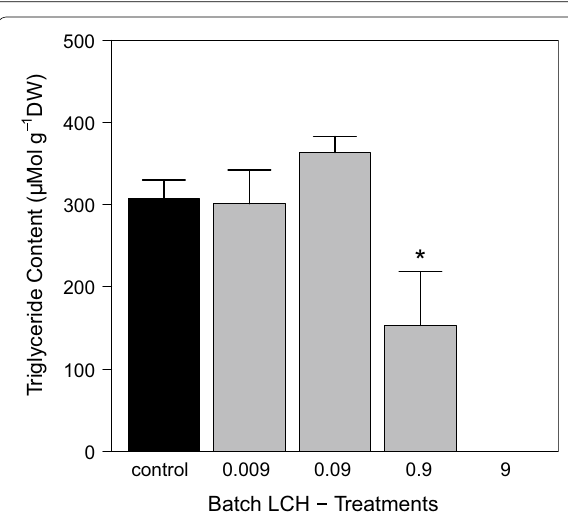
Fig. 12 a Grazer mortality at the end of the batch experiment [mean 2-parameter Logit model after correction of control mortality according to Abbott. Dotted lines indicate the 95 % confidence level. Treatment names according to the nominal LCH loads in µg g − 1 OC as described in Table 1